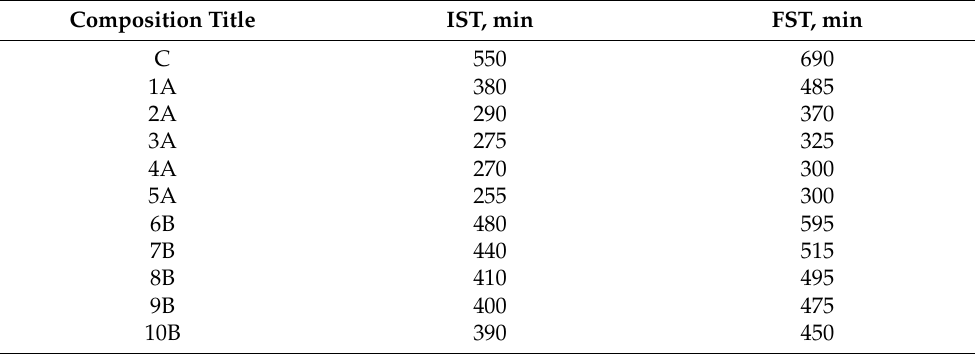
Table 9. Setting parameters of geopolymer composites with different types of stone flour.